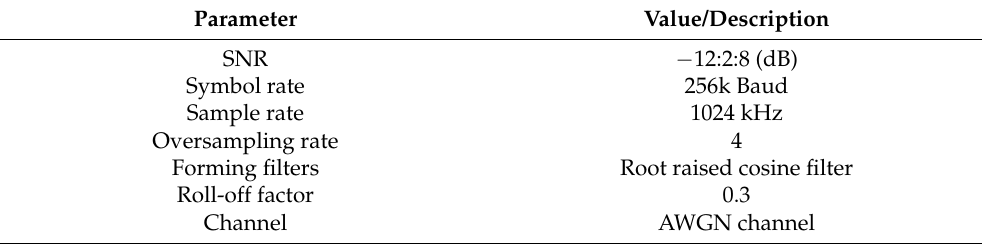
Table 2. Parameter settings for data sample